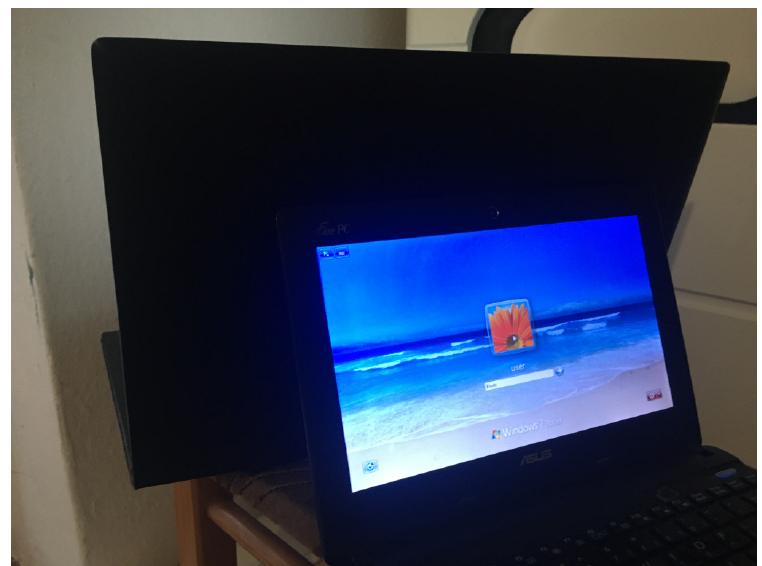
Figure 8. Scene view with two computers. A computer with a screen directly visible to the camera is a source of interference. The transmission is made by the computer screen facing away from the camera by reflection from the wall.